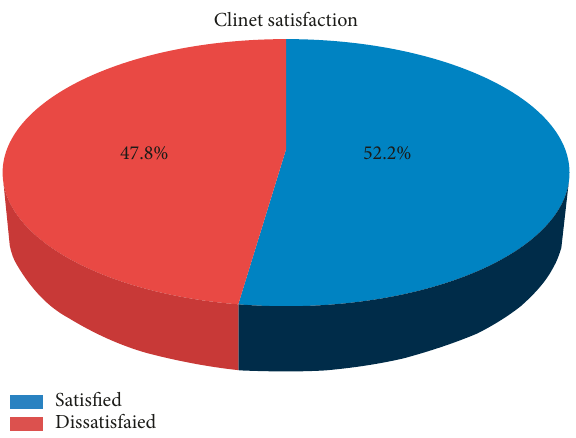
Figure 1: Overall client satisfaction in outpatient service of DURH, South Ethiopia, 2021 ( n � 412). Table 5: Predictors of client satisfaction in the OPD of DURH, Ethiopia, 2021 ( n �